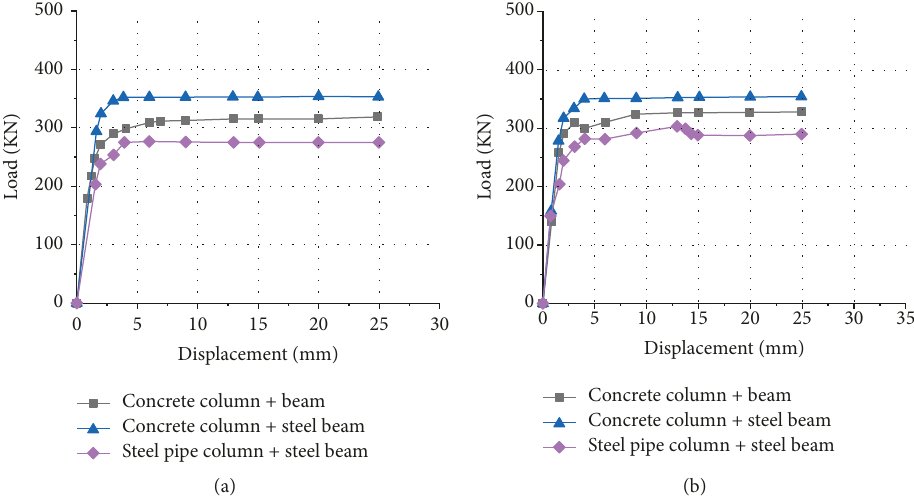
Figure 6: Impact curve: (a) bolt-type combination; (b) external diaphragm-type